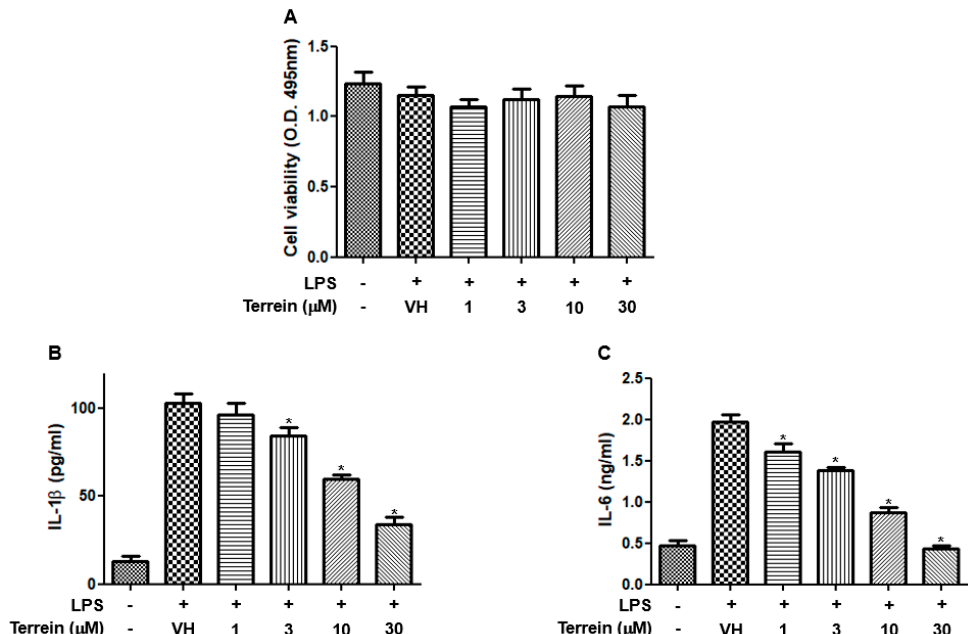
Figure 4. Effect of terrein on LPS − induced production of inflammatory cytokines in RAW 264.7 cells. RAW 264.7 cells were pretreated with the indicated concentrations of terrein for 1 h before being incubated with LPS (200 ng/mL) for 24 h. ( A ) Cell viability was analyzed using XTT assay. The production of IL − 1 β ( B ) and IL − 6 ( C ) were measured using ELISA. Each column shows the mean ± standard deviation of quadruplicate determinations. Significance was determined using Dunnett’s t − test versus vehicle − treated group (* p < 0.05).